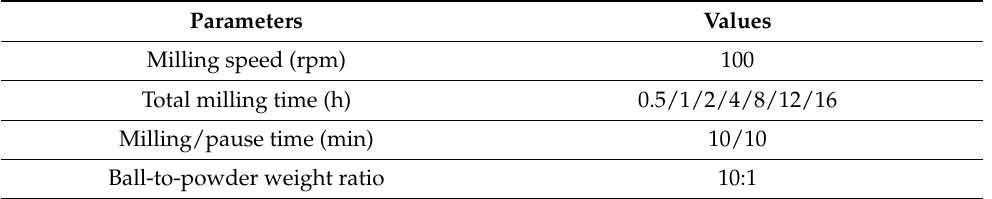
Table 1. The processing parameters for the seven samples of the advanced Gr/AA2024 composites.